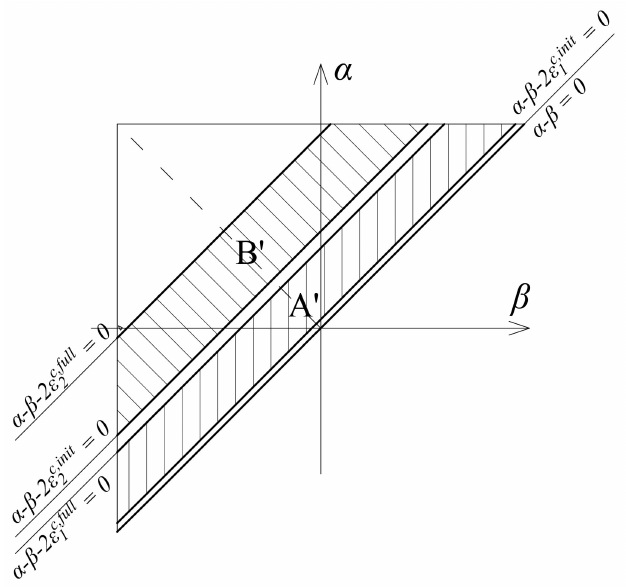
Figure 6. The Preisach triangle for the material model defined by Equation